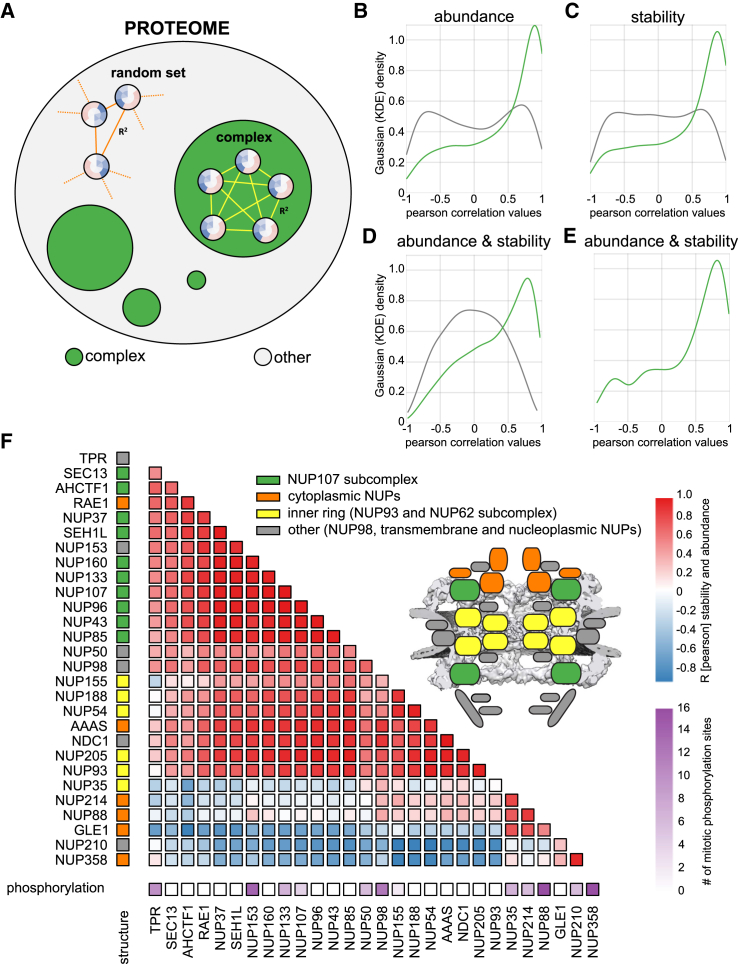
Co-stability of Known Protein Complexes and Submodules of the NPC(A) Schematic illustration of correlation analysis (see STAR Methods for further details).(B–D) Density graph of correlation coefficient values (Pearson) calculated from abundance (B), stability (C), and concatenated abundance-stability (D) profiles between proteins known to be members of the same complex (green). The gray density shows correlation values from all combinations of proteins not associated with any complex.(E) Density graph of correlation values (Pearson) calculated from concatenated abundance-stability profiles of all subunits of the nuclear pore complex (NPC).(F) Correlation matrix of NPC subunits based on their concatenated abundance-stability profiles. The colors on the left indicate their association with a specific substructure of the NPC, as colored in the respective cartoon. The scale on the bottom of the matrix indicates how many mitotic phosphorylation sites the corresponding protein subunit contains as described by Olsen et al. (2010).See also Figure S5 and Table S2.